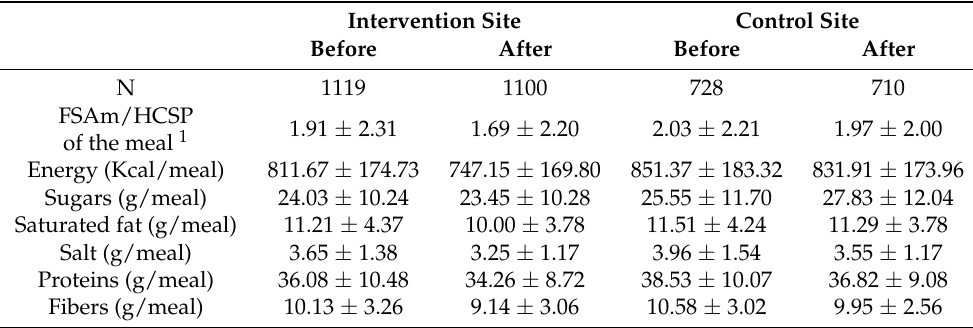
Table 2. Mean nutritional quality of means and nutrient intake per meal according to the period of the study and intervention and control sites in the Nutri-Score catering trial.